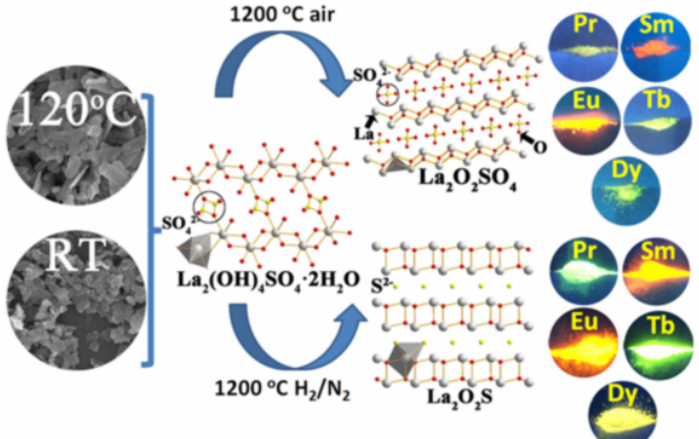
Fig. 8 (La,RE) 2 O 2 SO 4 oxysulfate and (La,RE) 2 O 2 S oxysulfide phosphors (RE = Pr, Sm, Eu, Tb, and Dy) derived with 241-L(La,RE)H as a green precursor for multi-color photoluminescence. Reproduced with permission from Ref. [9], © Elsevier B.V.